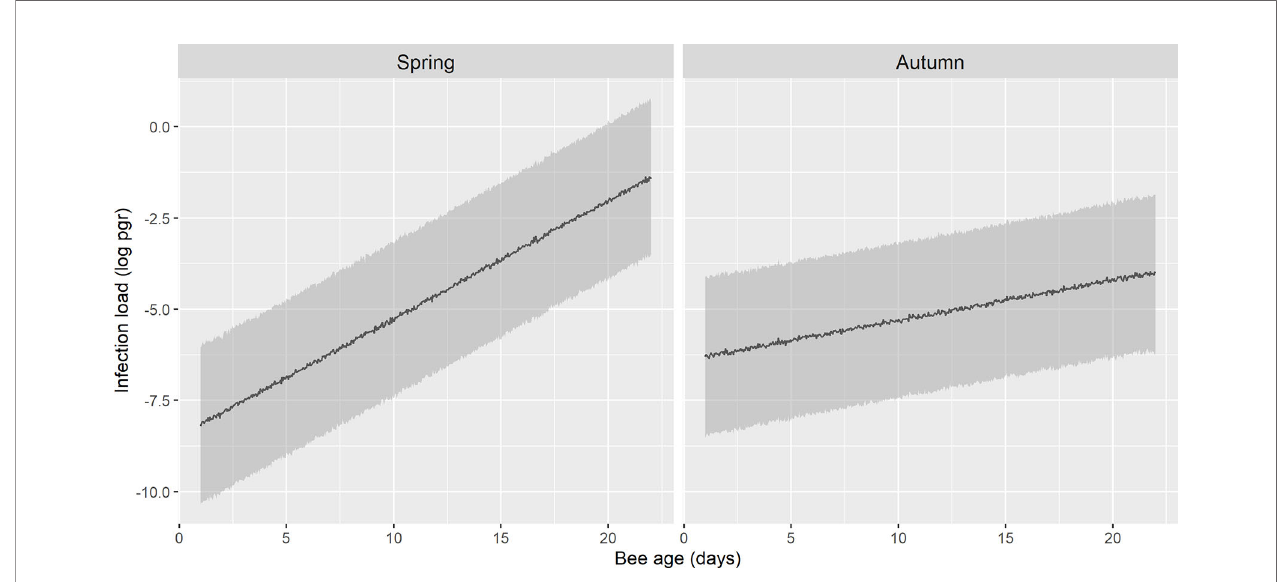
FIGURE 5 | Prediction of N. ceranae-PTP3 load of picograms in logarithmic scale (log pgr) in infected bees in spring and autumn. The load in spring is lower during the initial days and it increases steeply, whereas in autumn the trend remains fl atter across the